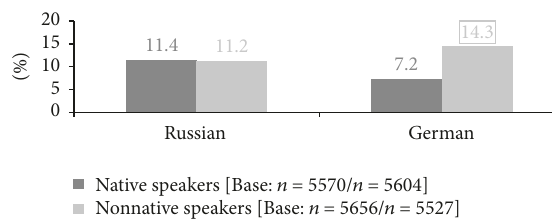
Figure 1: Influence of the signal-to-noise ratio on detection of speech signal in noise.